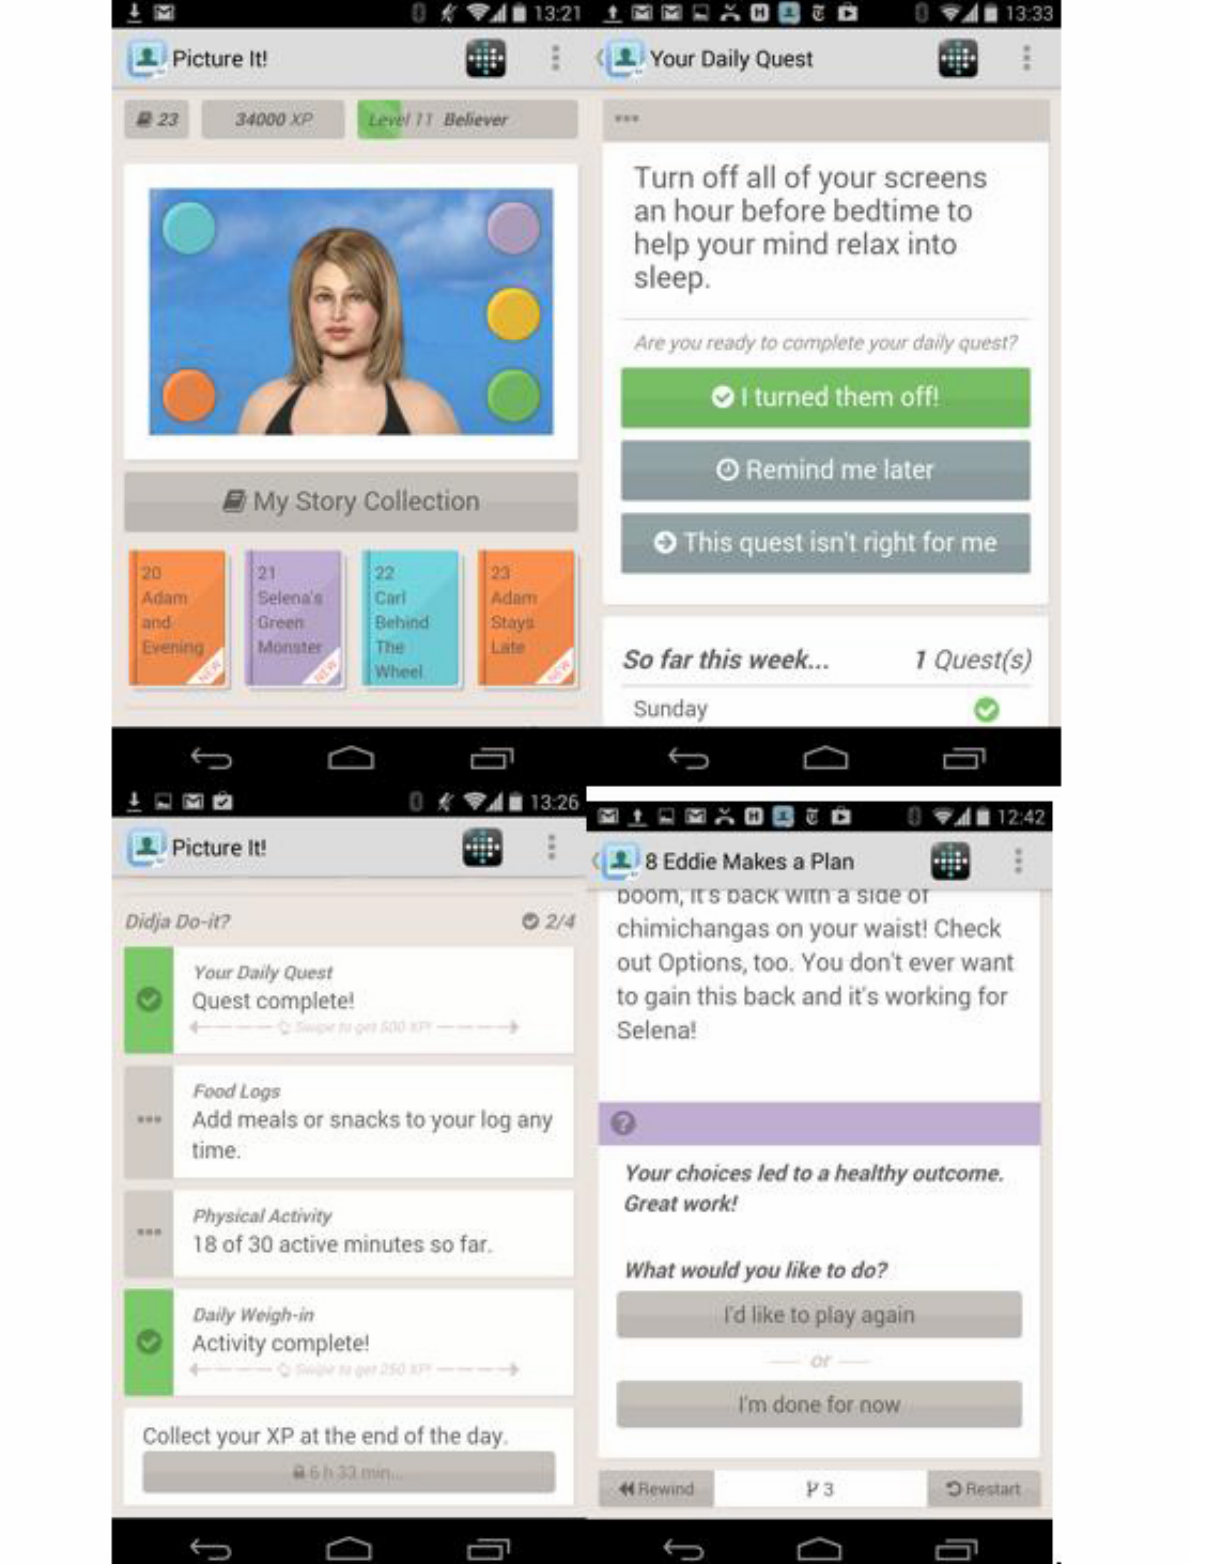
Figure 2. Screenshots of Picture It! with fitbit